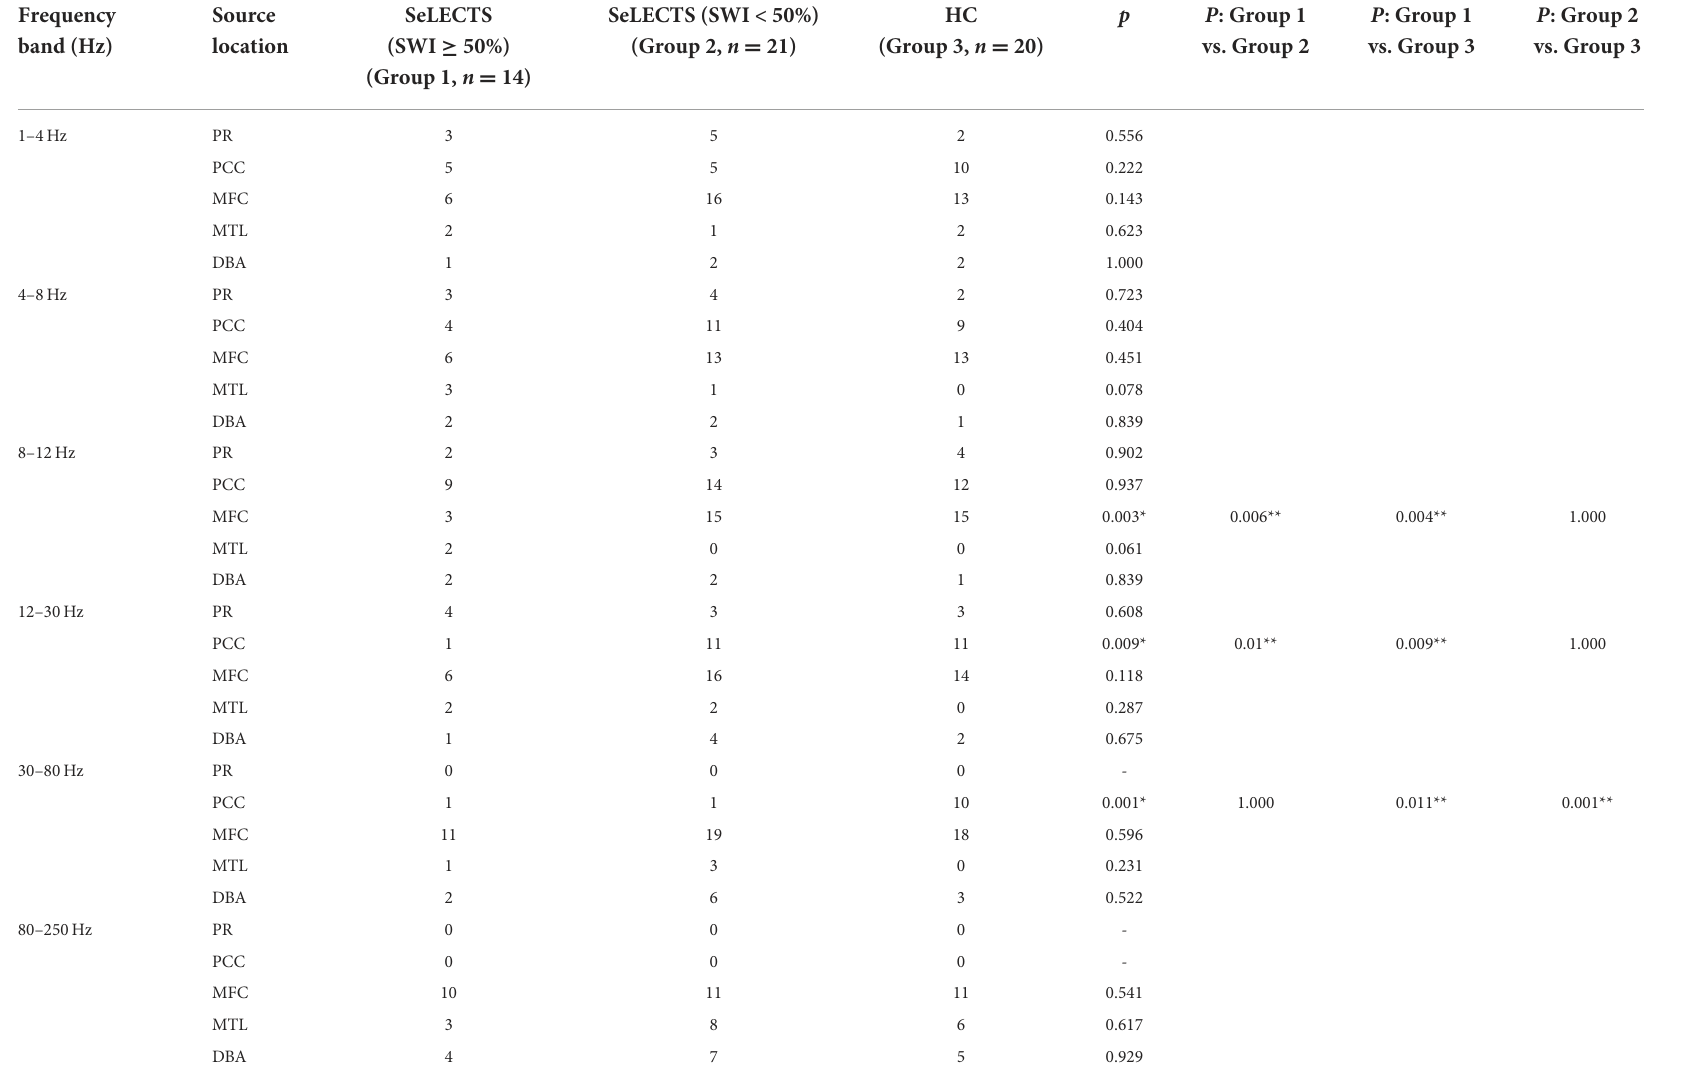
TABLE 3 Comparison of predominant neuromagnetic activity in the SeLECTS (SWI ≥ 50%), SeLECTS (SWI < 50%), and HC groups.